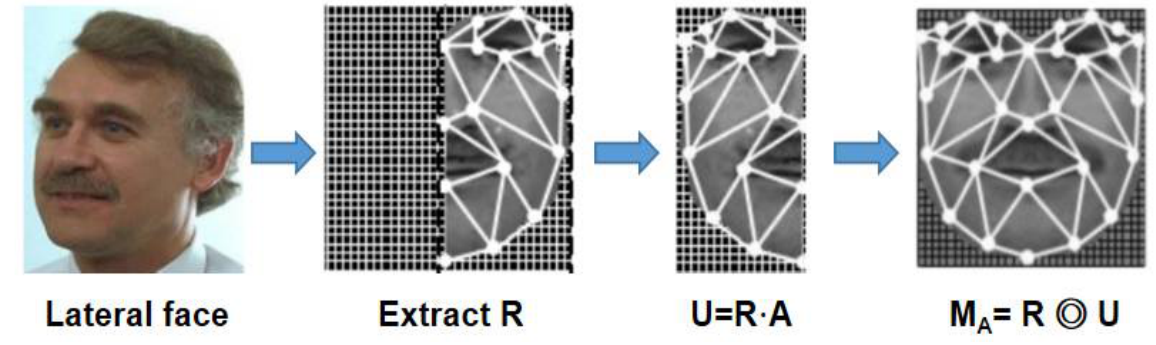
Figure 5. Fusion of two half faces.